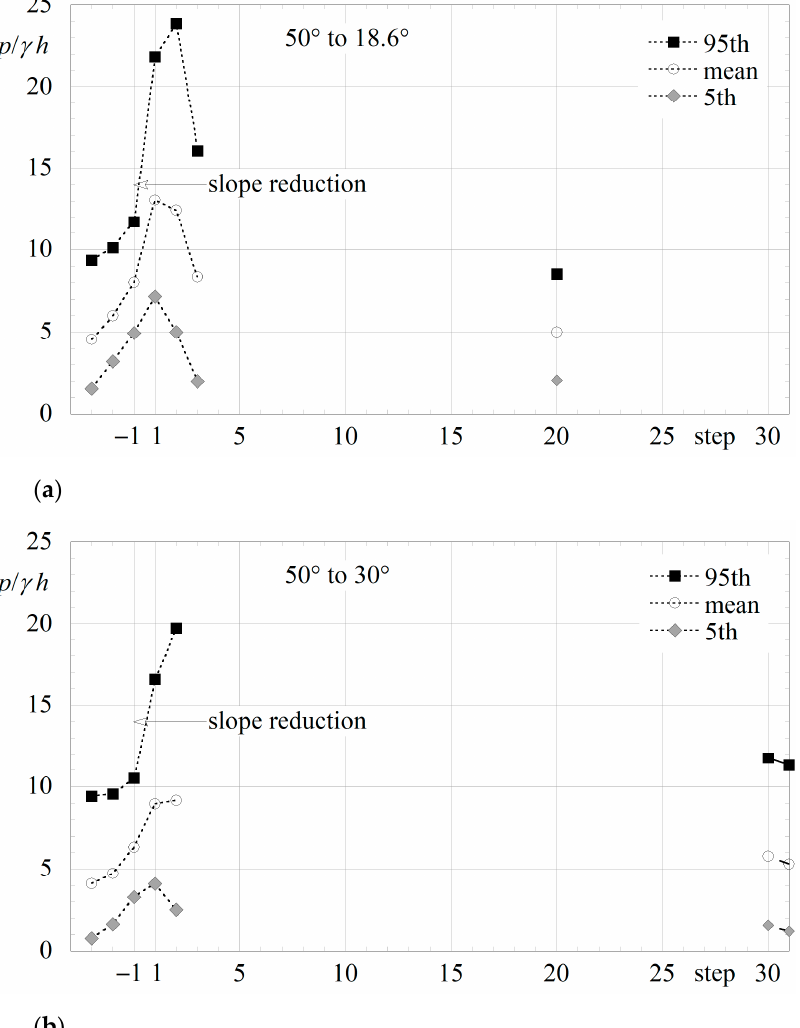
Figure 6. Development of the dimensionless pressure p /( γ h ) for d c / h = 4.6, for ( a ) the 50° to 18.6° slope reduction, at x / l = 0.35 on the 50° sloping chute and x / l = 0.3 on the 18.6° sloping chute, and ( b ) the 50° to 30° slope reduction, at x / l = 0.35 on the 50° sloping chute and x / l = 0.17 on the 30° sloping chute.